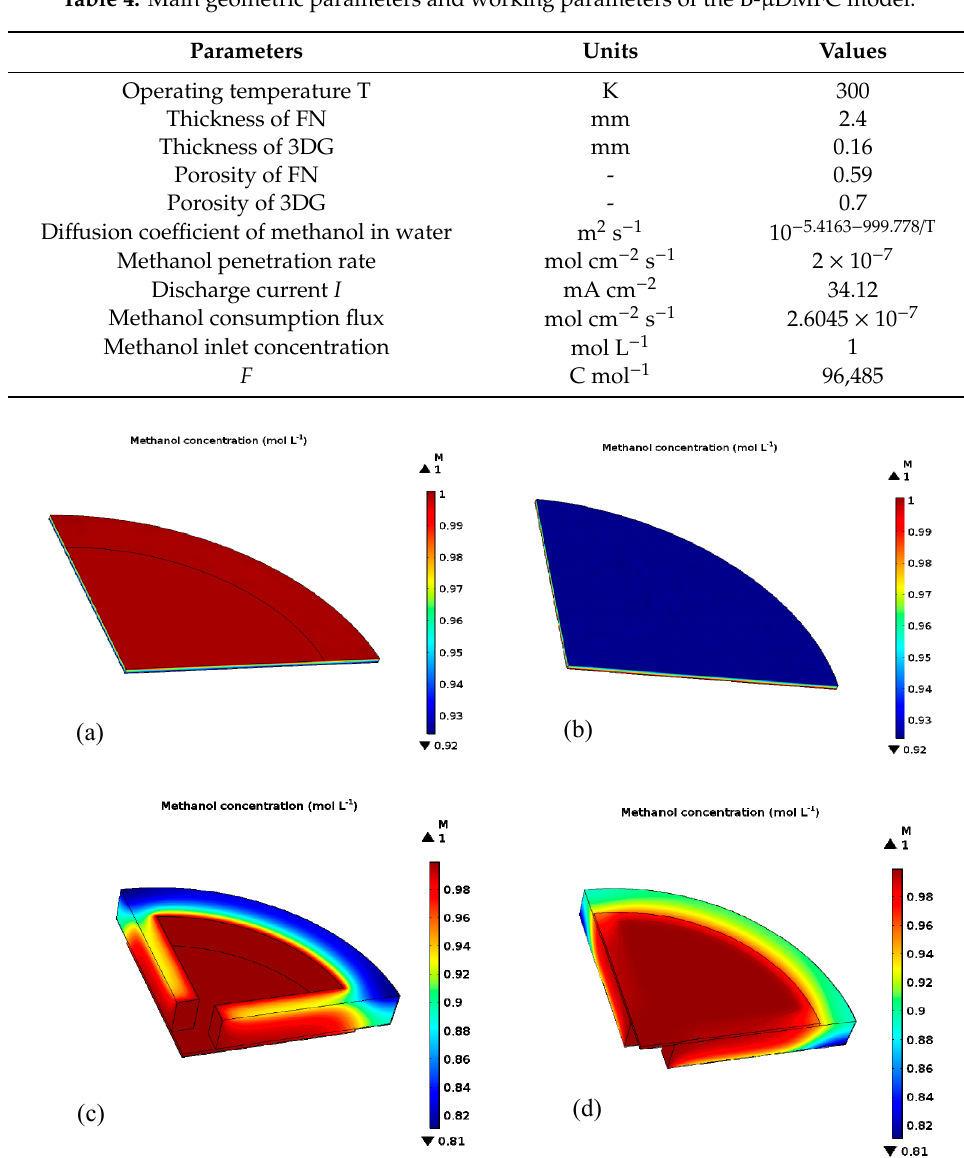
Figure 10. ( a ) Front view of methanol concentration distributions in the gas diffusion layer (GDL) of the 3DG + S structural cell; ( b ) back view of methanol concentration distributions in GDL of the 3DG + S structural cell; ( c ) front view of methanol concentration distributions in the 3DG + FN structural cell; ( d ) back view of methanol concentration distributions in the 3DG + FN structural cell.